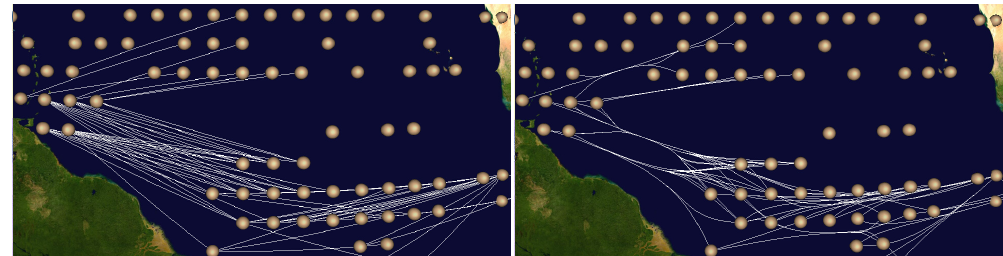
Figure 17. Surface air temperature network (GTX) zoomed to the equatorial Atlantic Ocean based on a node betweenness filtering ( ≥ 100000) and a geodesic edge length filtering ( ≥ 1656km), illustrating the effect of edge bundling: straight edges (left panel) and bundled edges (right panel).